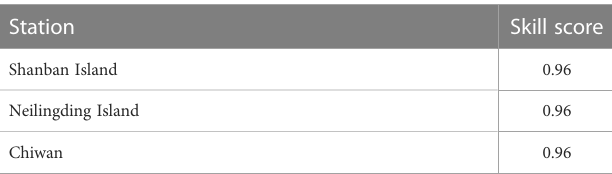
TABLE 3 Skill scores from comparison of model with observations. Station Skill score